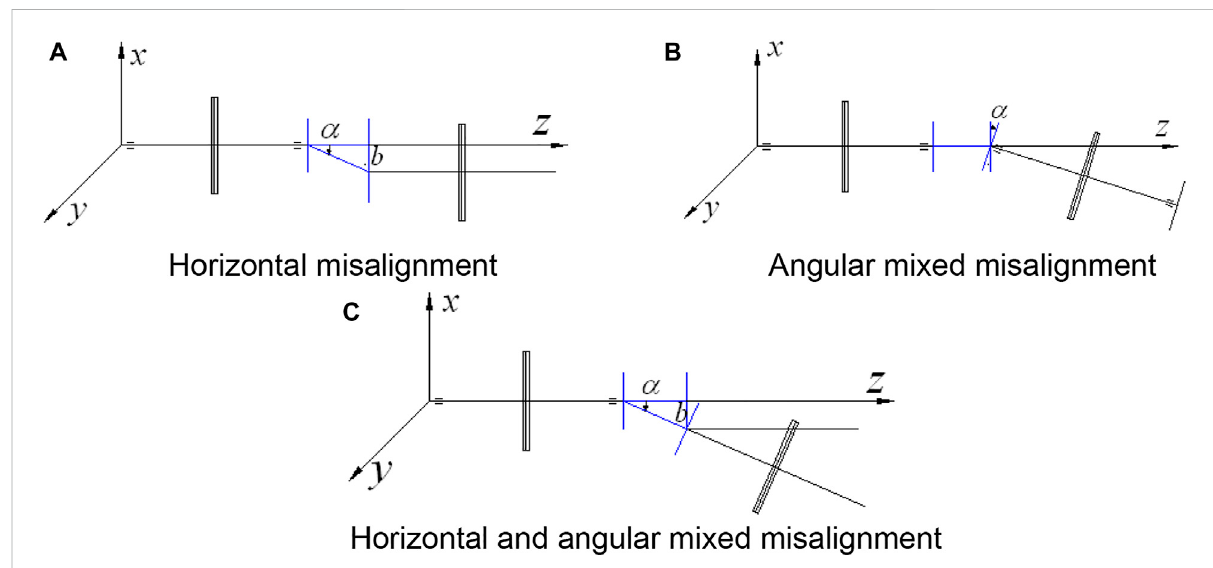
FIGURE 10 Various misalignment states of diaphragm coupling. (A) Horizontal misalignment (B) Angular mixed misalignment (C) Horizontal and angular mixed